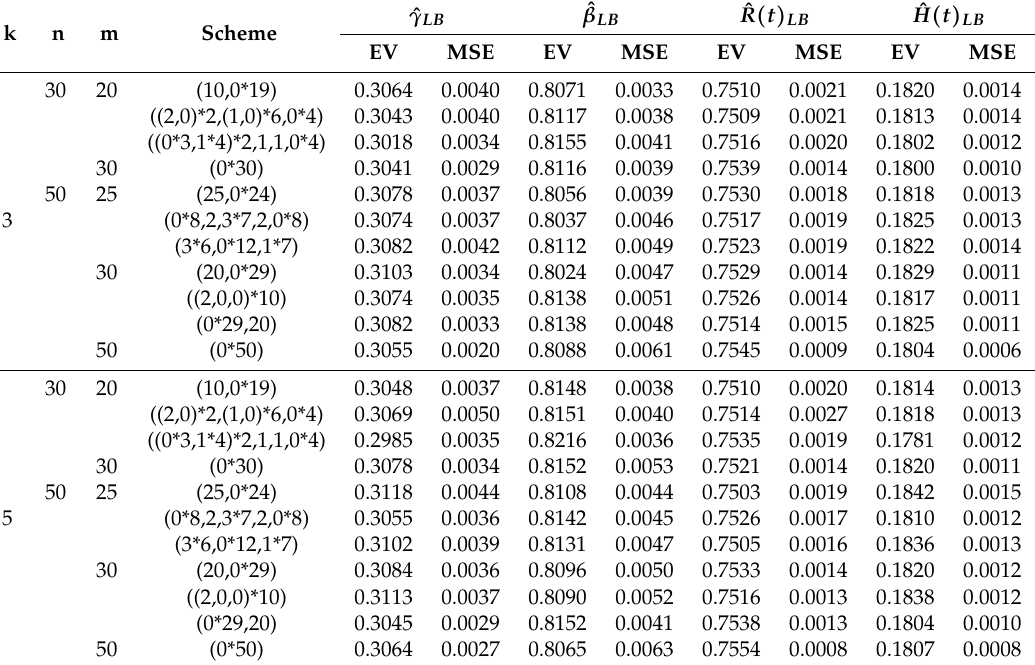
Table 8. Lindley approximation values and MSEs of parameters and reliability and hazard functions under GELF when q = − 0.5, γ = 0.3, β = 0.8, t = 1.5, a 1 = 1.08, b 1 = 3.6, a 2 = 16, b 2 = 20,